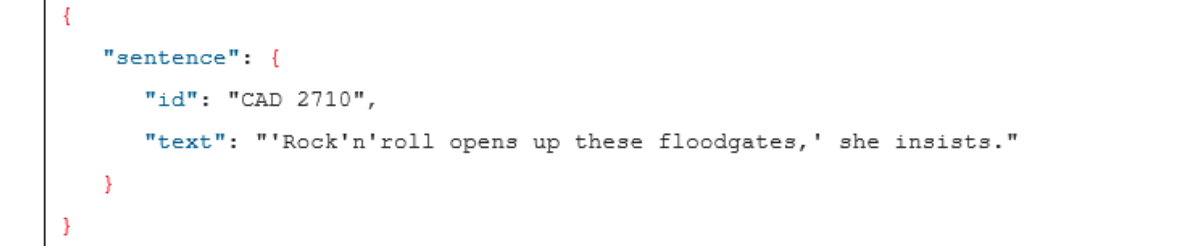
Figure 7. A sample sentence from the BNC formatted in JSON.